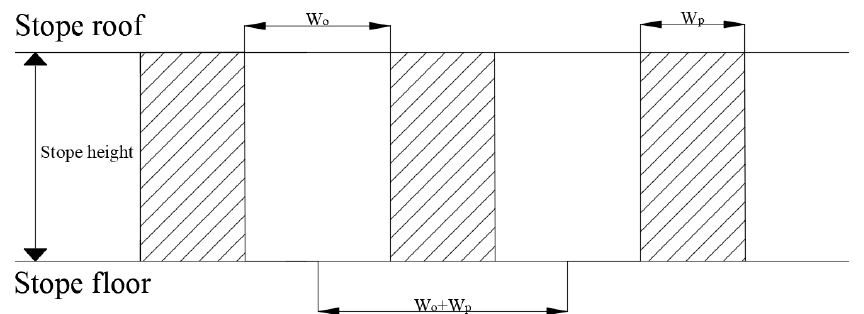
Figure 1. Schematic diagram of pillar stress.